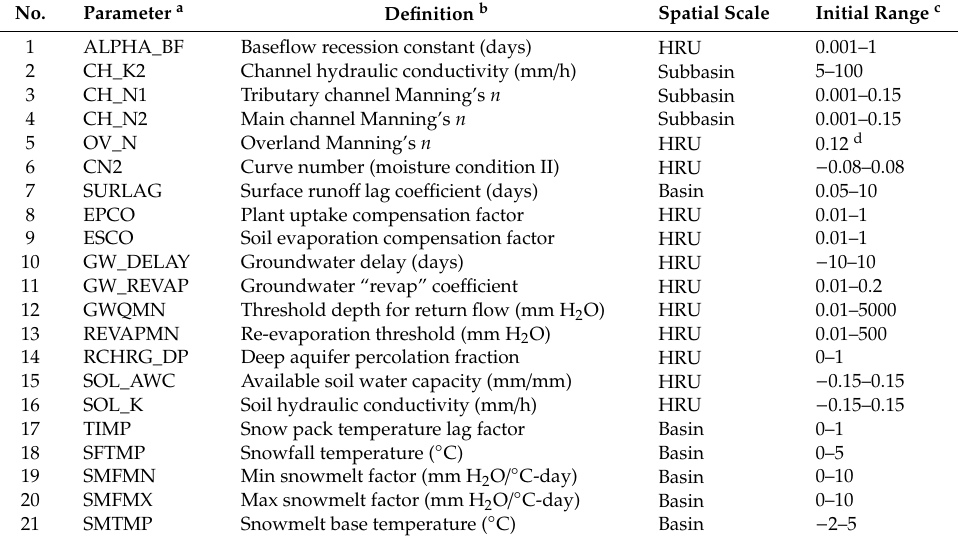
Table A1. Parameters included in the streamflow calibration of the Cedar River Watershed model. See supplementary information for the most optimal parameter